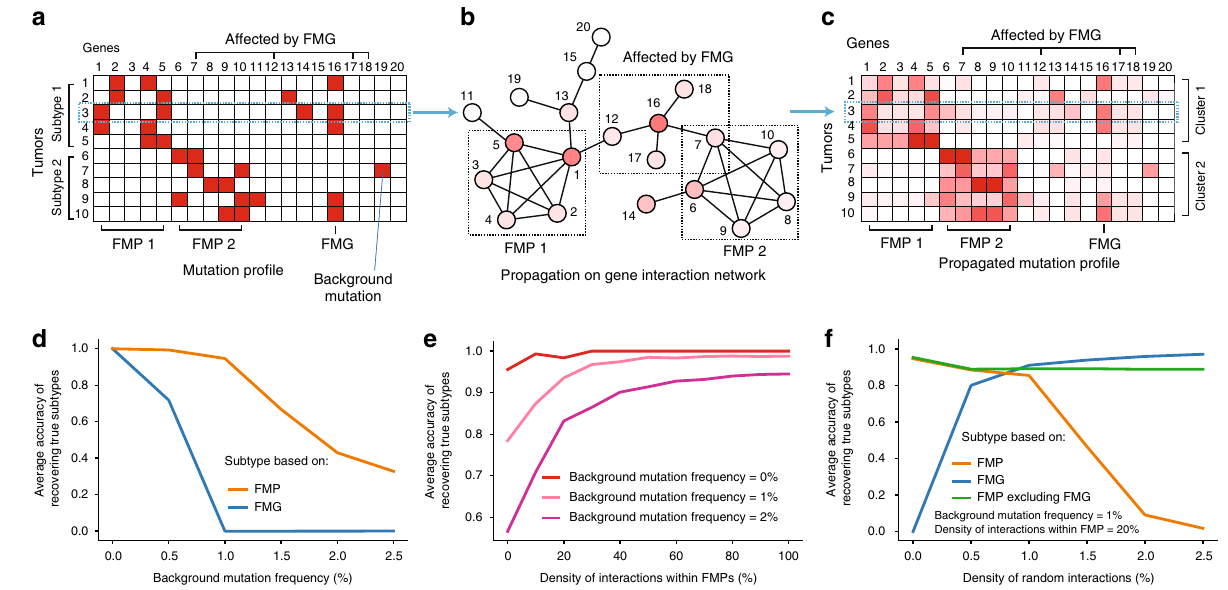
Fig. 1 Exploring cancer pathway analysis through simulation. a Simulated somatic mutation dataset including two FMPs (genes 1 – 5) and an FMG (gene 16). Mutated genes are shown in red and non-mutated genes are shown in white. A reduced set of tumors and genes (10 × 20) is shown as an example; the full simulation is (1000 × 1000). b Network-based propagation of mutations over a simulated gene interaction network. Shades of red show propagated mutation values for tumor sample #3. c Mutation dataset from a following network propagation. d Tumor strati fi cation performance with increasing frequency of background mutations, when no random interactions are presented. Performance is measured by calculating Adjusted Random Index (ARI) between the true subtypes and the tumor clusters derived by network strati fi cation. e Tumor strati fi cation performance with increasing density of interactions within FMPs, when no random interactions are presented. f Tumor strati fi cation performance with increasing random gene interaction